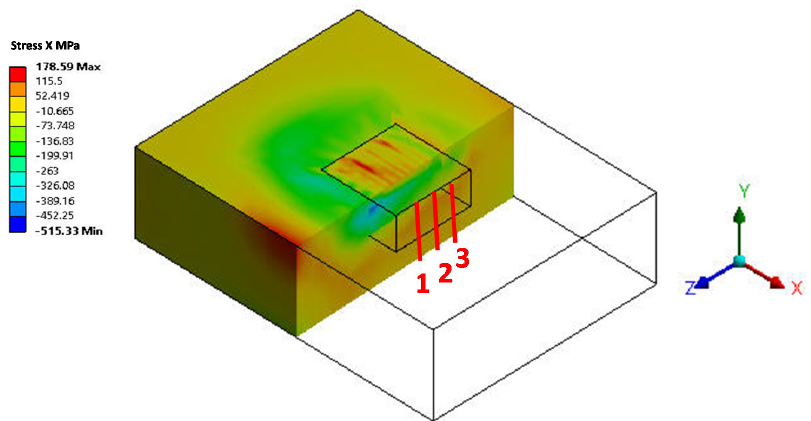
Figure 6. Representative residual stress estimation along the cross-sectional depth of the burnished area. Lines 1, 2, and 3 indicate the depth lines along which stress is estimated.